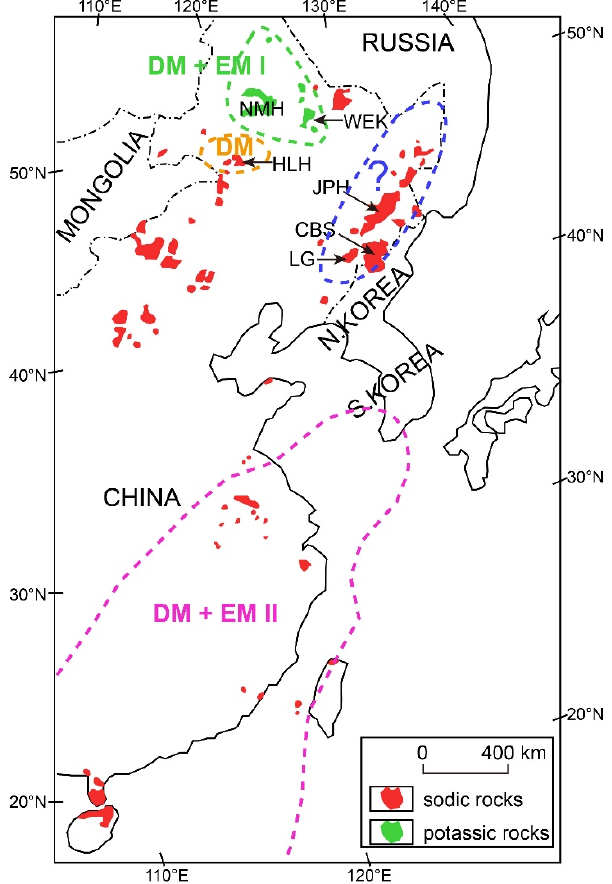
Figure 1. Spatial distribution of Cenozoic basalts across east China (modified from [4,7]), color-coded as either potassic or sodic. While all appear to share a depleted upper mantle (DM) source, the potassic Nuomihe (NMH) and Wudalianchi–Erkeshan–Keluo (WEK) volcanic fields (inside green dashed line) incorporate an enriched EM I component, while volcanoes across a broad SE China region (inside magenta dashed line) are characterized by an EM II component. Halaha (HLH) lava (inside yellow dashed line) has neither of these additional enriched mantle signatures [8]. The sources of the sodic lavas in the blue dashed line are still under debate. Other sodic volcanic fields: JPH = Jingpohu, CBS = Changbaishan, LG = Longgang.